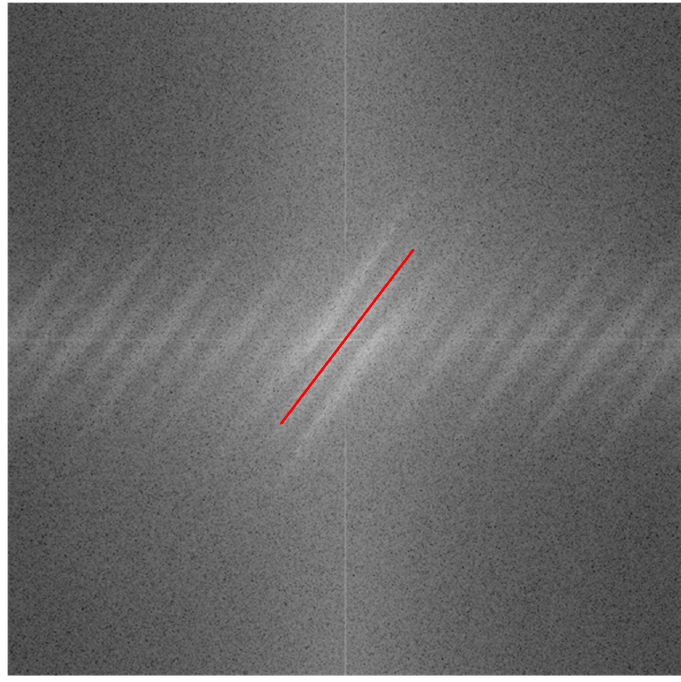
Figure 14. Main direction of spectrum by